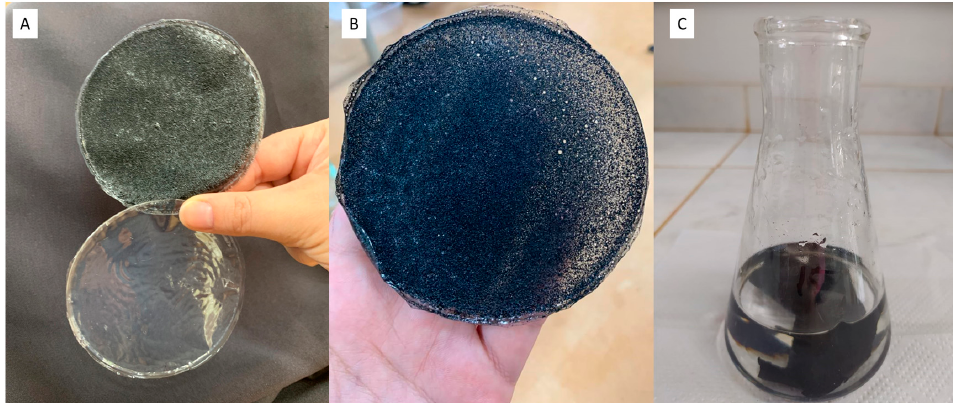
Figure 2. ( A ) Cellulose acetate film without (pure) and with bonechar; ( B ) cellulose acetate film with bonechar; ( C ) visualization of the attachment of the material to the film (translucent water after 24 h of agitation).